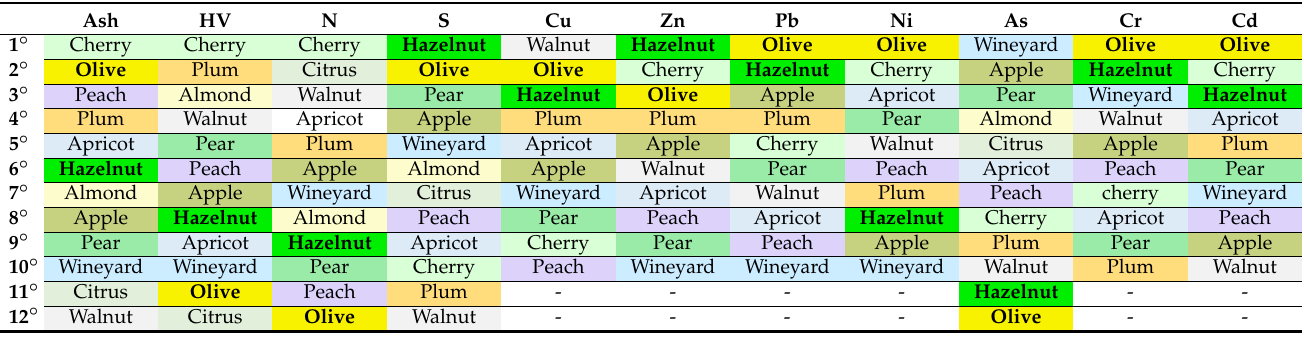
Table 10. Qualitative classification of the parameters for each species (1st: most satisfactory values; 12th: least satisfactory values). Each species was highlighted by a different